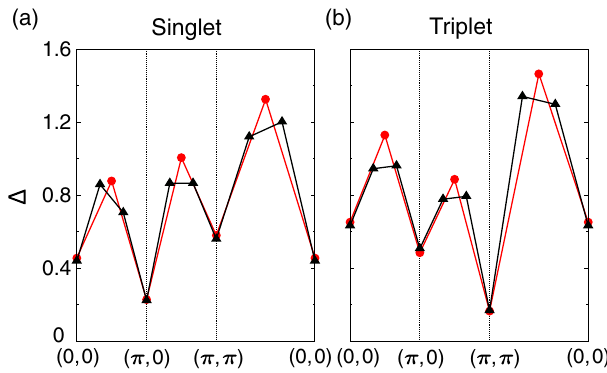
FIG. 17. f ↑↓ ij sublattice-size dependence of excitation. (a) Sin- glet and (b) triplet excitation energy along the symmetric line in the Brillouin zone for 12 × 12 lattice. Red dots, 4 × 4 sublattice structure. Black triangles, 6 × 6 sublattice structure.